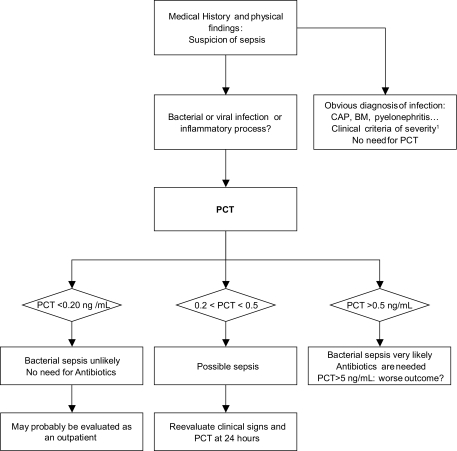
Suggested diagnostic strategy based on PCT levels in EDs.1Systolic Blood Pressure less than 90 mmHg, mottling, oliguria, lactate >2 mmol/L or other signs of septic shock or trouble CSF after lumbar puncture, obvious clinical presentation of community-acquired pneumoniae (thoracic symptoms, fever, and consolidation on chest x-ray).